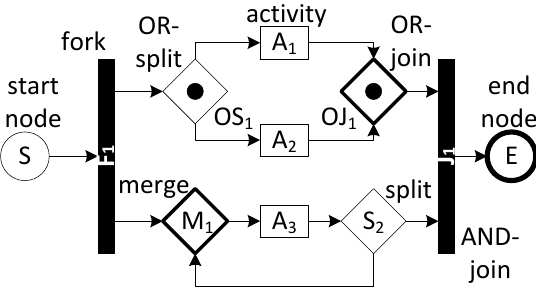
Figure 3. A workflow graph with